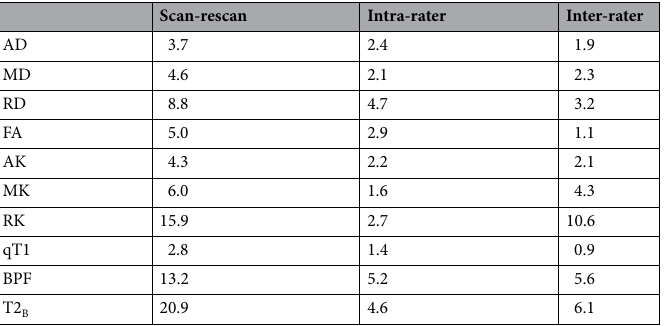
Table 2. Percent coefficient of variation (%COV) results of the standard DTI metrics axial/radial/mean diffusivity (AD/RD/MD) and fractional anisotropy (FA), DKI metrics axial/radial/mean kurtosis (AK/RK/